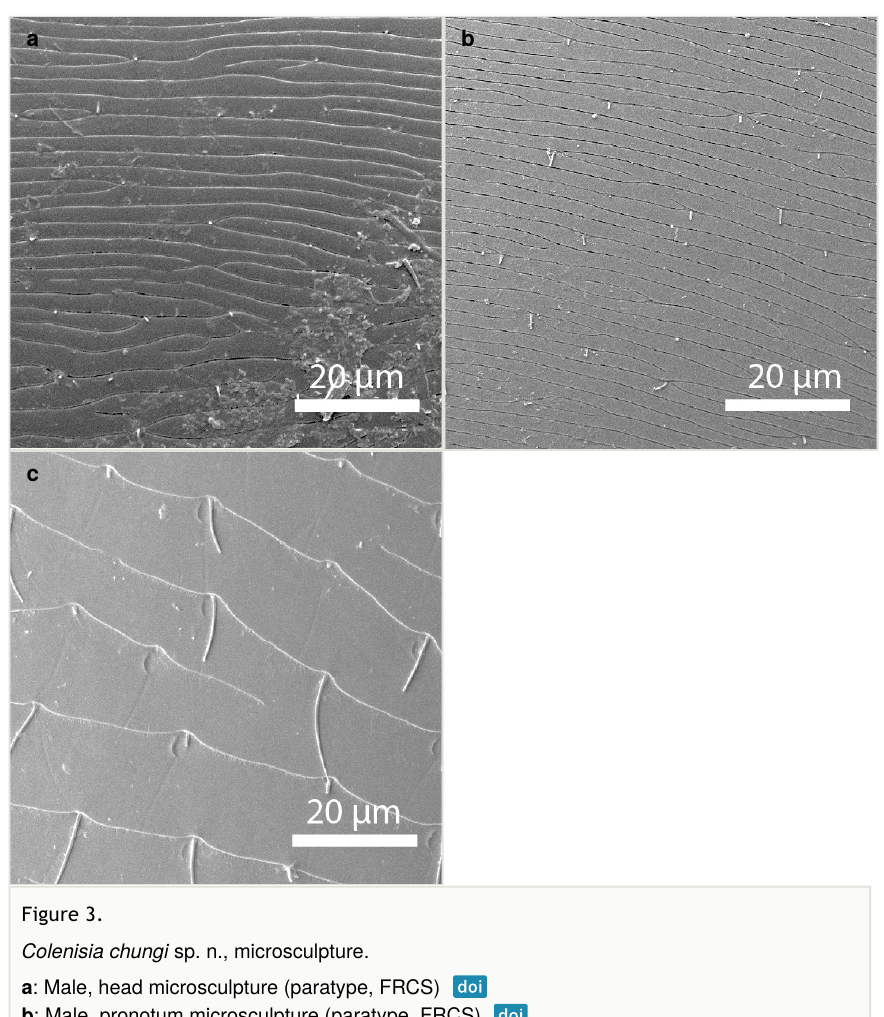
magni fi cation, no punctuation is clearly visible. Length of antennomere III 0.8 times the length of antennomere II. Antennomere XI slightly wider than antennomere X (Fig. 5a). Mandible with 16 parallel rows transversely situated on the dorsal molar surface (Fig. 5b).